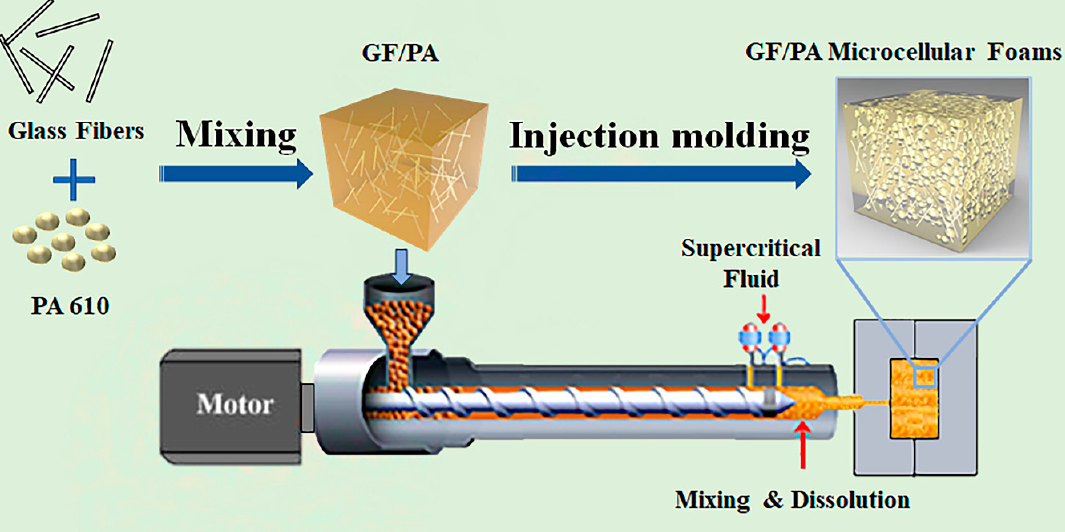
Figure 1. The molding flow chart of glass fiber ‐ reinforced nylon (GF/PA) microcellular foams. Table 1. The experiment factors and